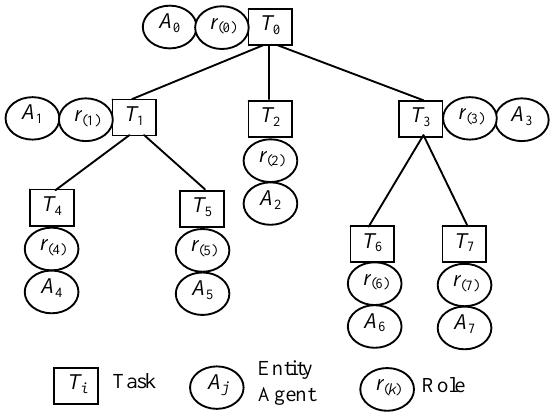
Fig. 2. Flexible coupling of task-(role)-entity agent.